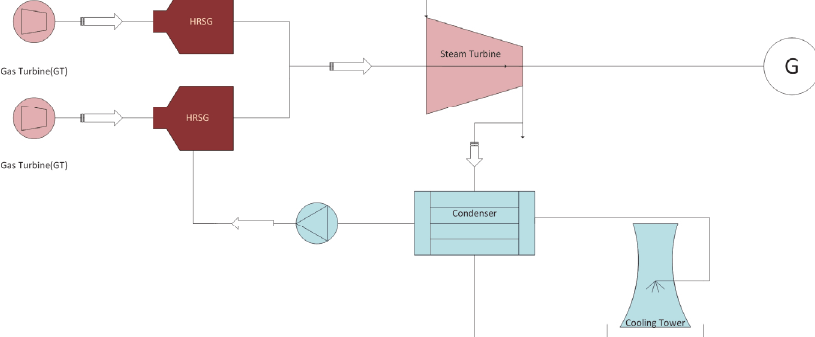
Fig. 1. Steam turbine and heat recovery steam generator